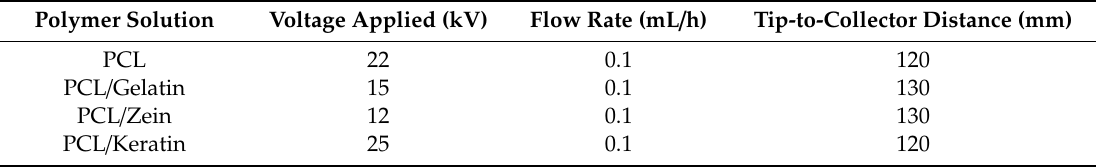
Table 1. Electrospinning parameters used to fabricate protein-rich